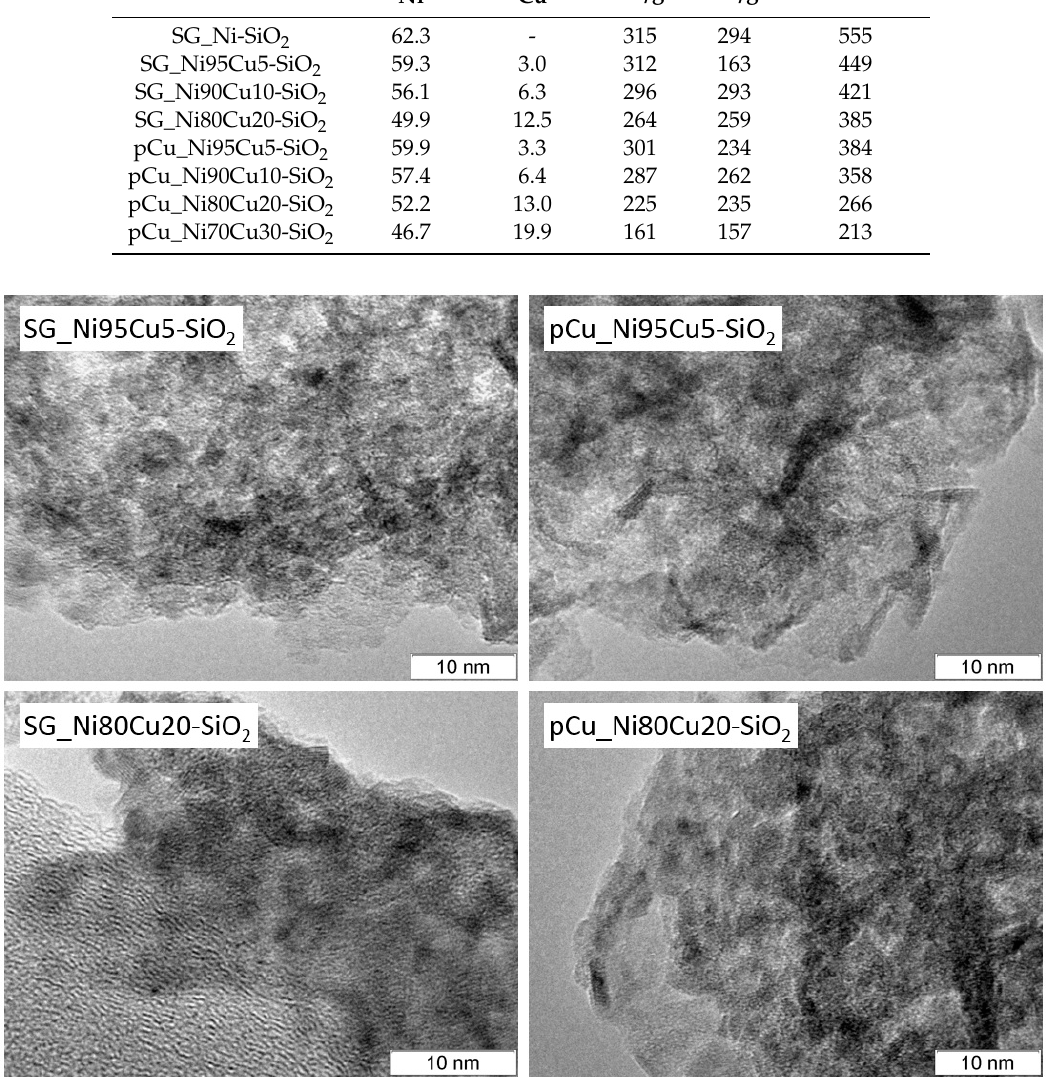
Figure 1. HRTEM images of SG_Ni95Cu5-SiO 2 , pCu_Ni95Cu5-SiO 2 , SG_Ni80Cu20-SiO 2 , and pCu_Ni80Cu20-SiO 2 catalysts after reduction at 400 °C and passivation. Images of better quality are presented in Supplementary materials.